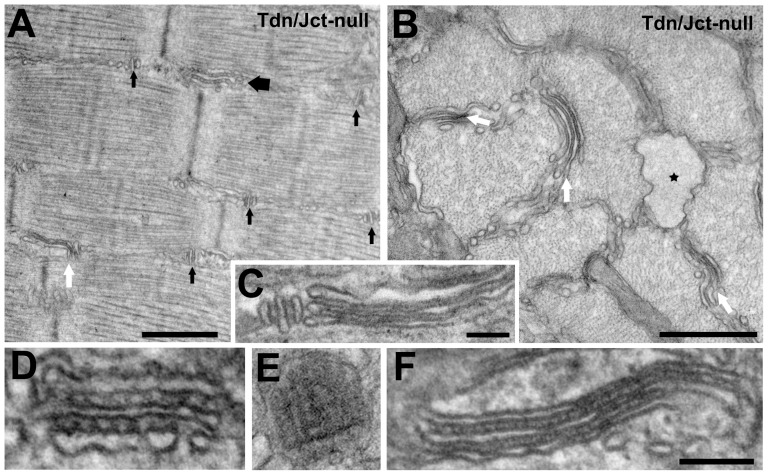
Additional structural alterations:a shift of triads orientation from transverse to longitudinal in fast twitch fibers of EDL and sternomastoid (A, larger arrow) resulting in the development of large jSR plaques carrying multiple rows of feet (D and E). This occurs in fast twitch fibers of Tdn-null fibers, as previously reported, and in the double null mutants. B) The double null mutant fibers show a small number of quite large sacs always located in correspondence of the Z-line (not shown) and filled with a finely granular material similar to the CASQ content of the jSR (star) and some flat SR cisternae (A, B, white arrows, C and detail in F). The flat SR cisternae are separated by small densities that are clearly different from feet (compare D and F, at the same magnification). Bars: A, 0.5 µm; B, 0.5 µm; C, 0.1 µm; D–F, 0.1 µm.